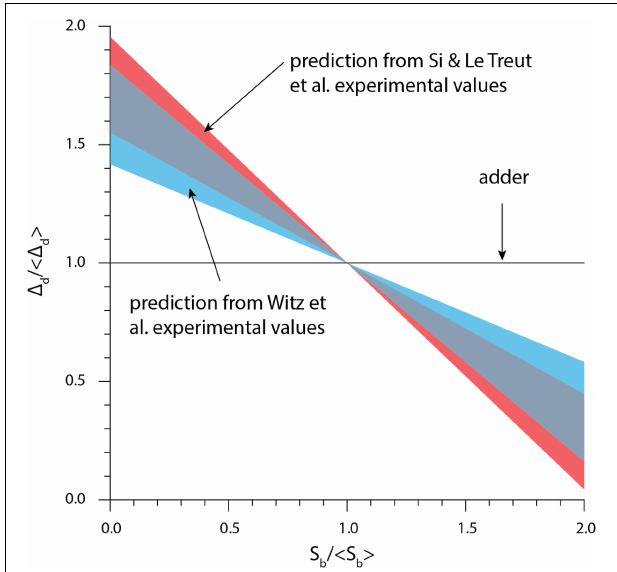
FIGURE 5 | The theory based on the initiation-centric model predicts a more sizer-like behavior. We used Eq. (1) and the experimental values of σ id / σ ii from Si et al. (2019), Witz et al.